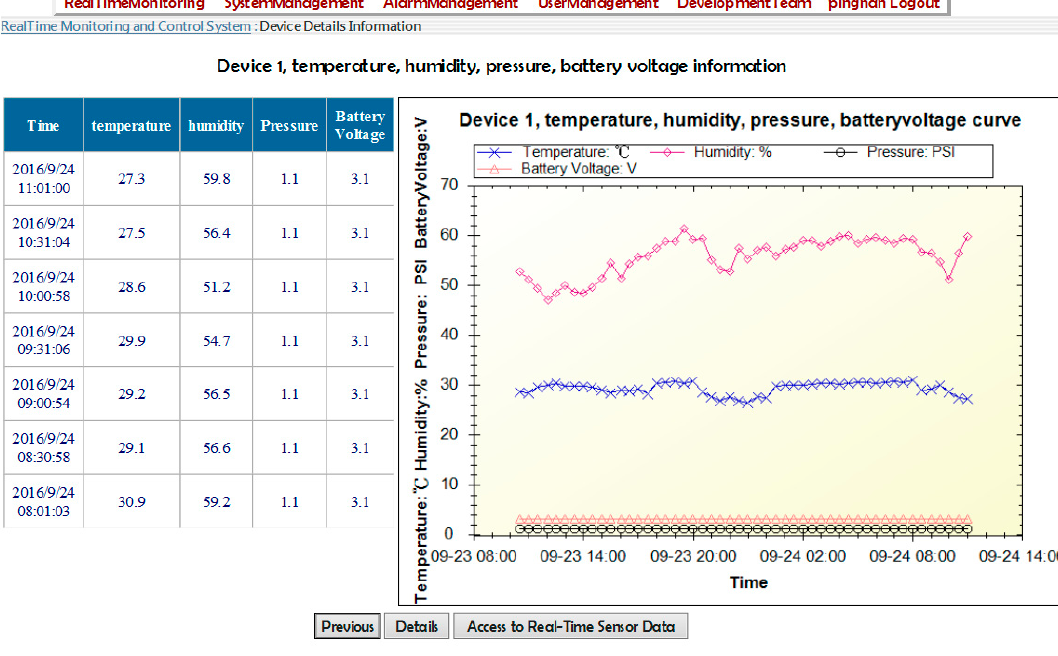
Figure 16. Scenario 1: real-time tracking of temperature, humidity, pressure, and battery power of Sensor 1.